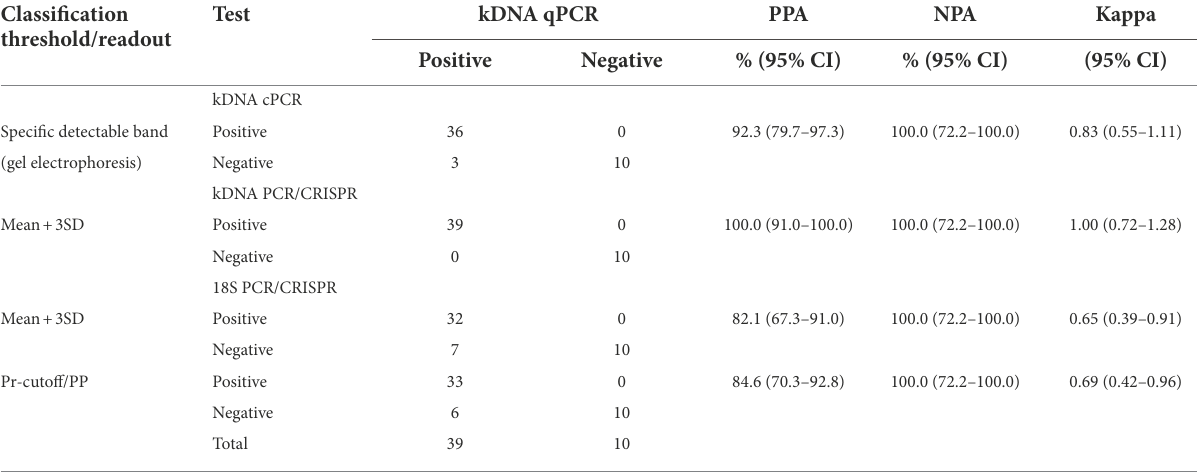
TABLE 1 Concordance analysis of molecular tests compared to the reference kDNA qPCR test for detection of Leishmania in clinical samples. Classification